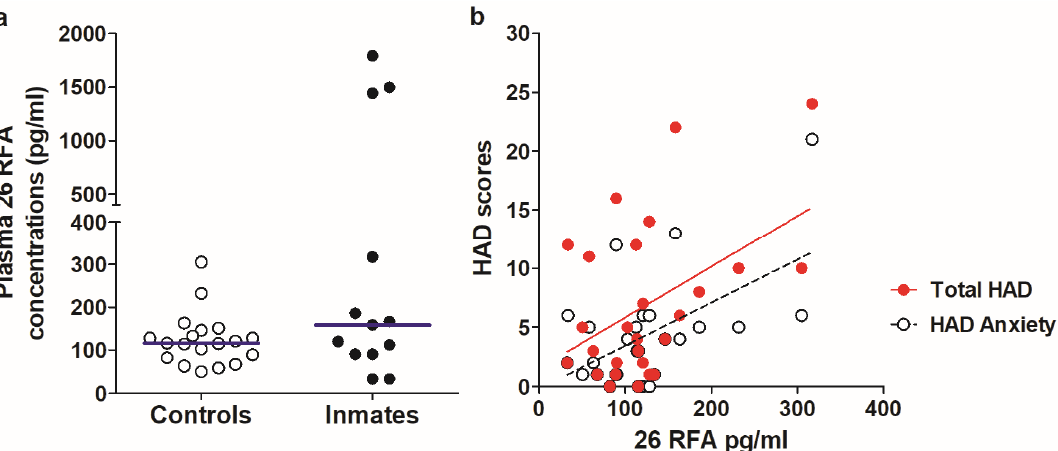
Figure 1. ( a ) Comparison of 26RFa plasma concentration between inmates who had committed violent aggression and men from the general population (Controls). Lines indicate the median levels in both groups. ( b ) Significant positive correlations between plasma concentration of 26RFa and HAD total and HAD Anxiety scores. High outliers in the inmate group have been removed from this correlation plot.